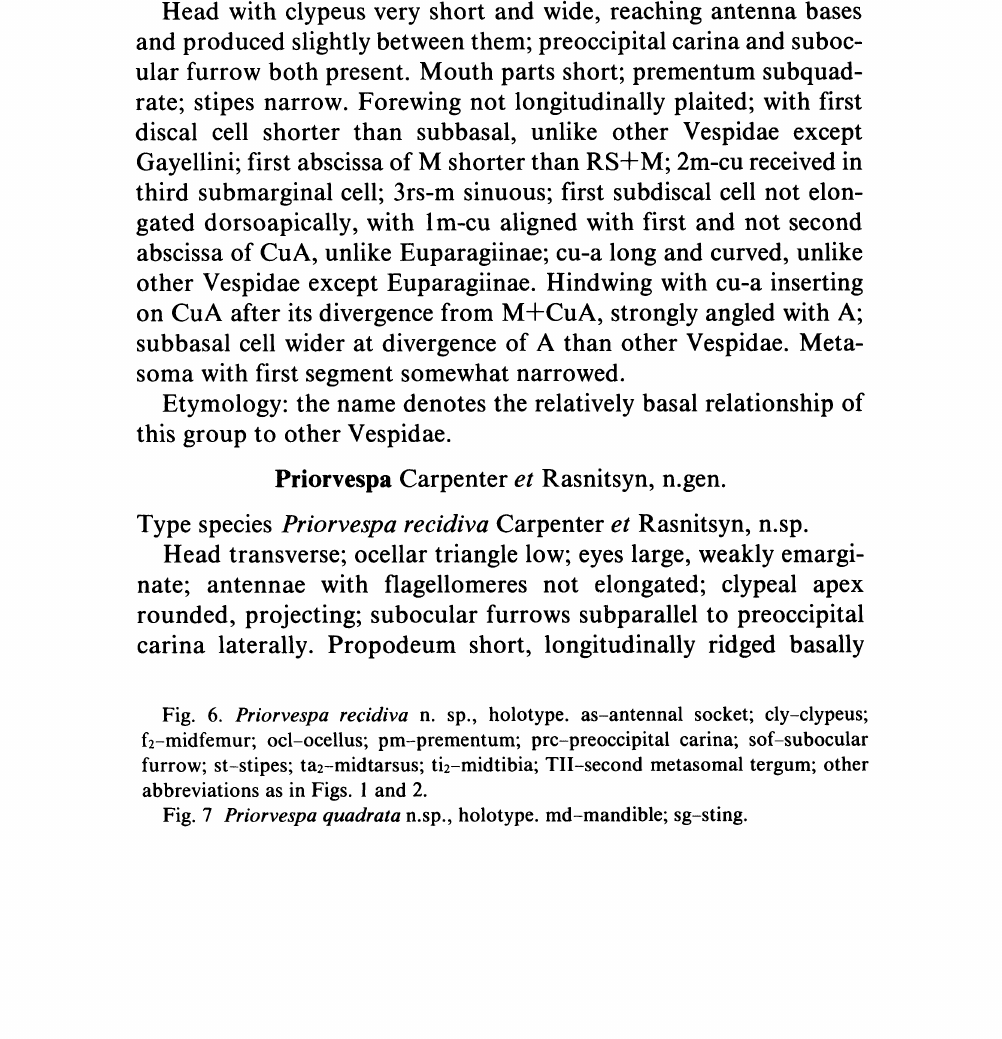
Fig. 7 Priorvespa quadrata n.sp., holotype, md-mandible;